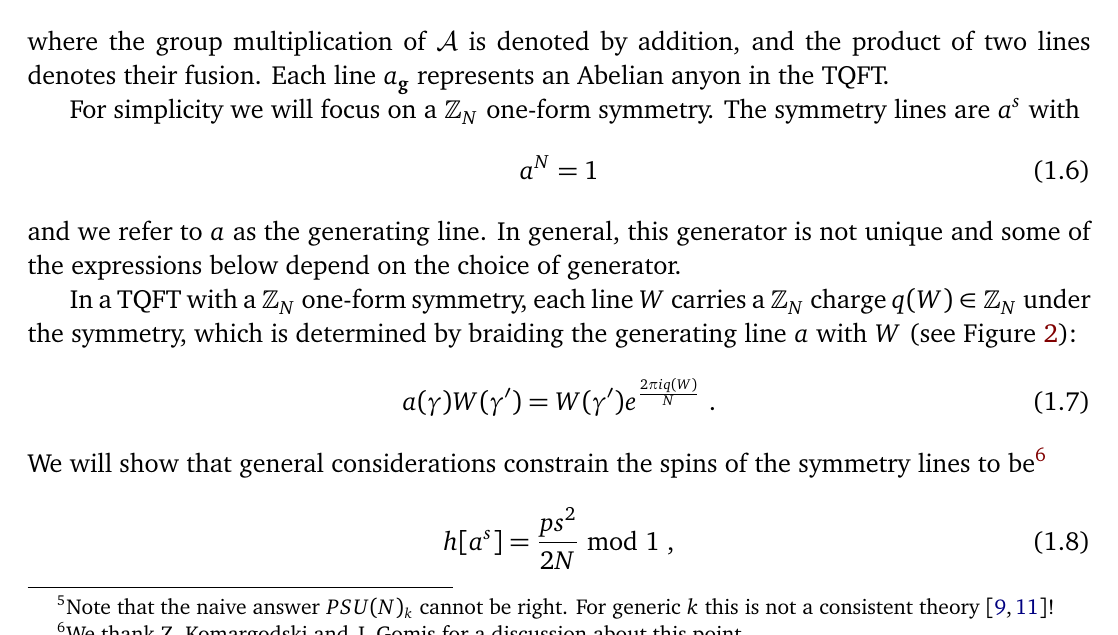
Figure 2: Braiding the line operators supported on the curves γ and γ (cid:48)